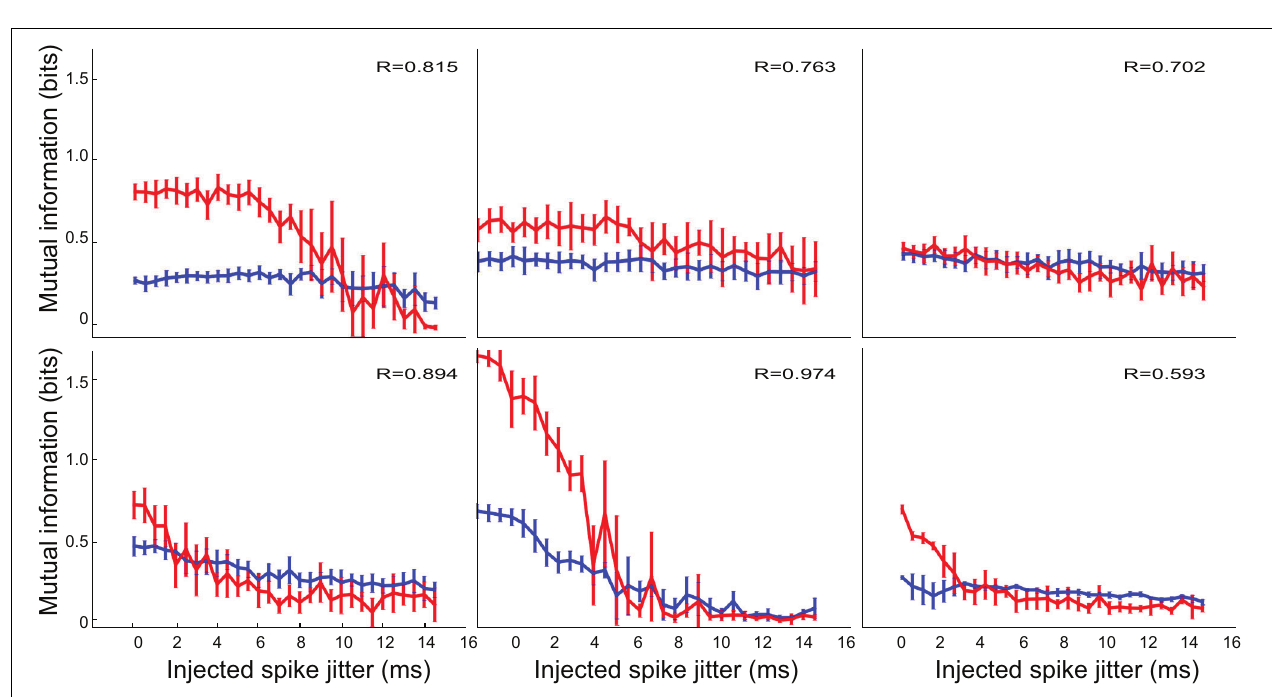
from rate coders (first two plots), to a highly precise and sensitive temporal coder (last plot). Here and on subsequent figures the value of the Pearson correlation coefficient R indicates the correlation between the control condition and the inhibition blocked condition, when one is considered a function of the other, with each jitter condition providing a point pair for the estimate.